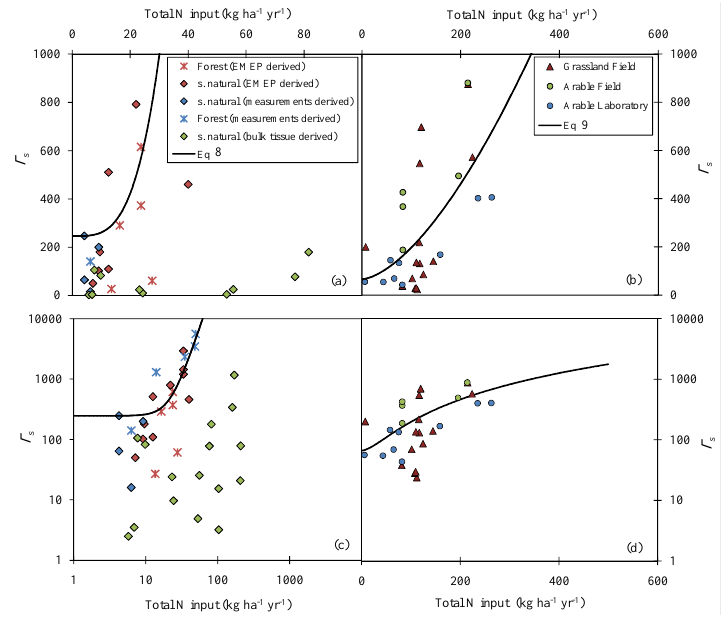
Fig. 5. (a) and (c) Compiled stomatal ammonia emission potential ( 0 s ) for non-managed ecosystem types as a function of total N input to the ecosystem on a linear and logarithmic scale respectively. Data are separated according to the data source of the N in value (EMEP model estimated, site-based measurements and bulk tissue derived values according to Eq. 7). Red and blue symbols have only atmospheric deposition as an N source and green symbols have atmospheric deposition as well as fertiliser as N source. The line is the best fit power function derived by minimisation of the least square method excluding data for laboratory based experiments (green symbols) (refer to text). (b) and (d) Compiled stomatal ammonia emission potential ( 0 s ) for managed ecosystem types as a function of total N input on a linear and logarithmic scale respectively. The black line is the best fit equation to the data points. Red triangles represent field grassland measurements, green and red circles represent field based and laboratory based measurements on arable crops respectively. Approximated fertiliser N input values for laboratory based experiments are given in Table